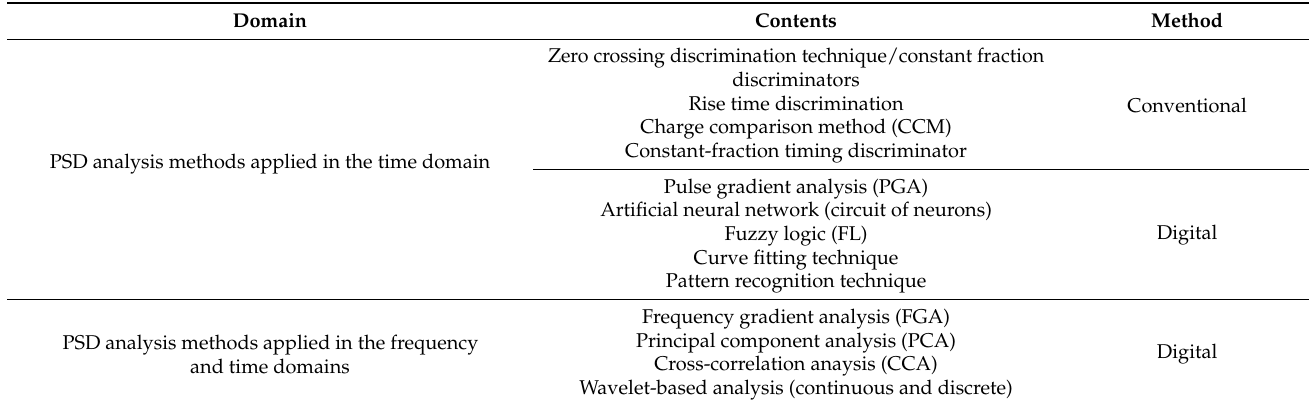
Table 3. PSD analysis methods in the time and frequency